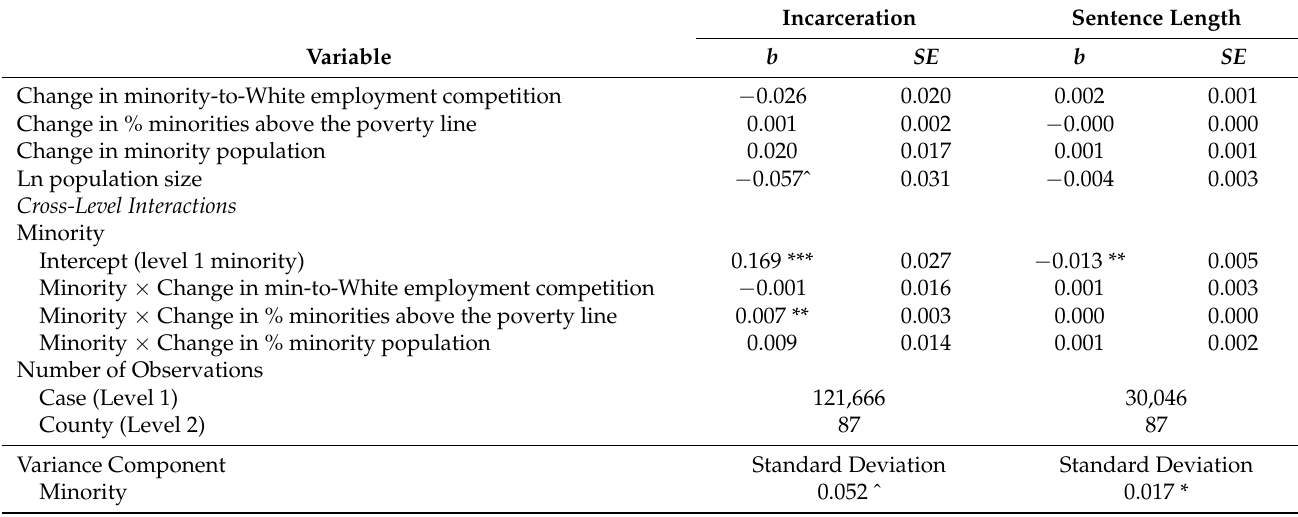
Table 3. Hierarchical OLS Regression Model of Incarceration and Sentence Length, County-Level Effects with Cross-Level